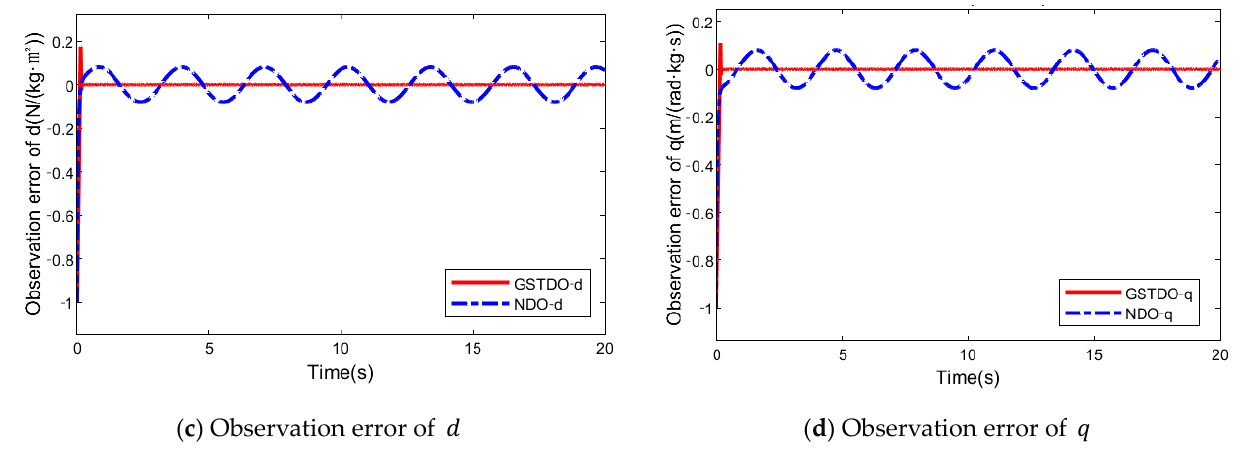
Figure 19. Comparison of the observation error of GSTDO and NDO in Experiment 3.